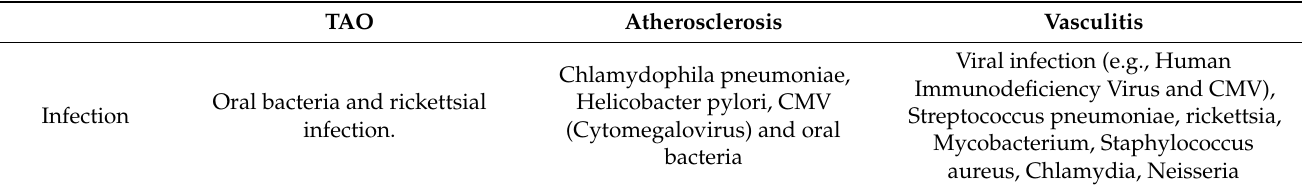
Table 6. Summary of the main findings on